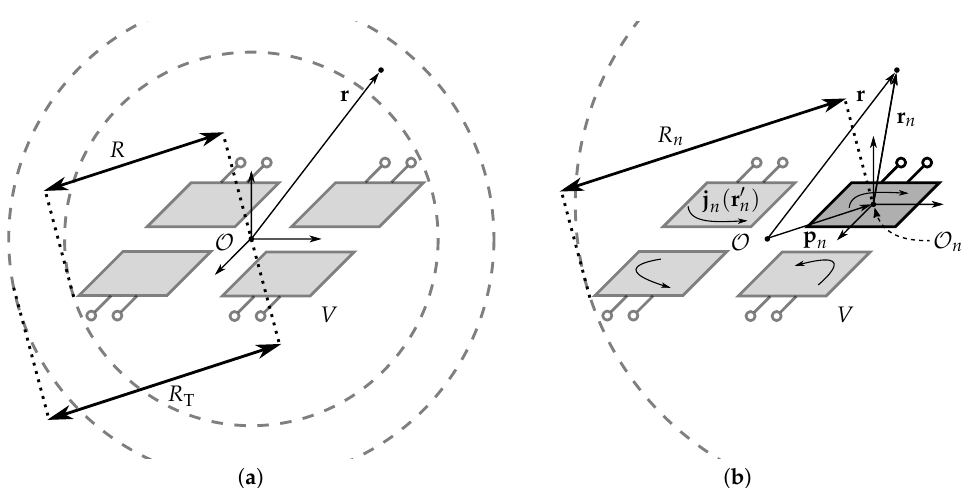
Figure 2. ( a ) Conceptual sketch of an array of volume V circumscribed by a sphere of radius R and with its phase center coinciding with the origin of the coordinate system shape the array’s emitted field so that it corresponds to a desired pattern on a sphere with radius R T . ( b ) Each n th array element, fed through the n th port, is attached to a local phase center, indicated by a vector p , and coinciding with a local coordinate system’s origin n sphere with regard to the local coordinate system has a radius R n . A current I n is injected into the n th port (see also Figure 3), generating a current distribution j